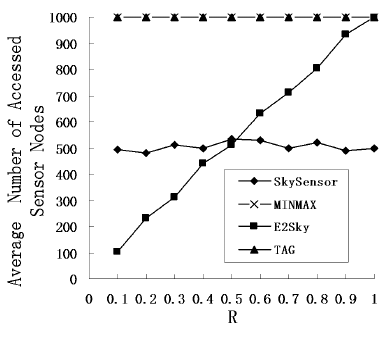
Figure 13. Average number of accessed sensor nodes under different values of R .